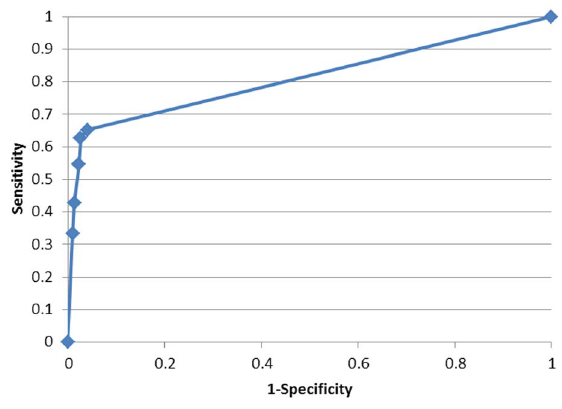
Figure 6. ROC curve for Philippines’ predictions four weeks in